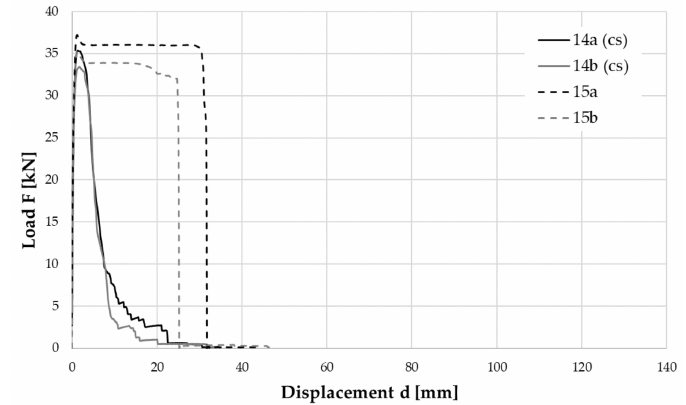
Figure 18. Tensile load-displacement response curves for samples 14a and 14b, with an oily component in the elastomer layers, and samples 15a and 15b, without